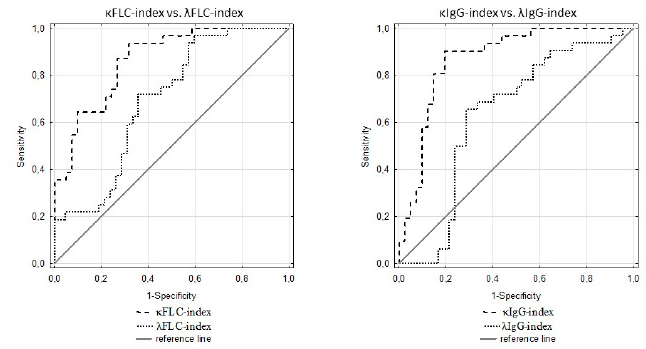
Figure 3. ROC curves for κ FLC index, λ FLC index, κ IgG index, and λ IgG index in multiple sclerosis.